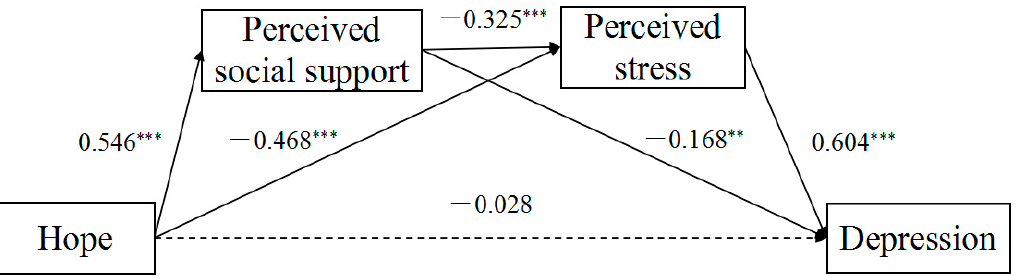
Figure 2. Associations between hope and depression for the whole sample ( N = 221). Note . Coeffi- cients are standardized. ** p < 0.01, *** p <